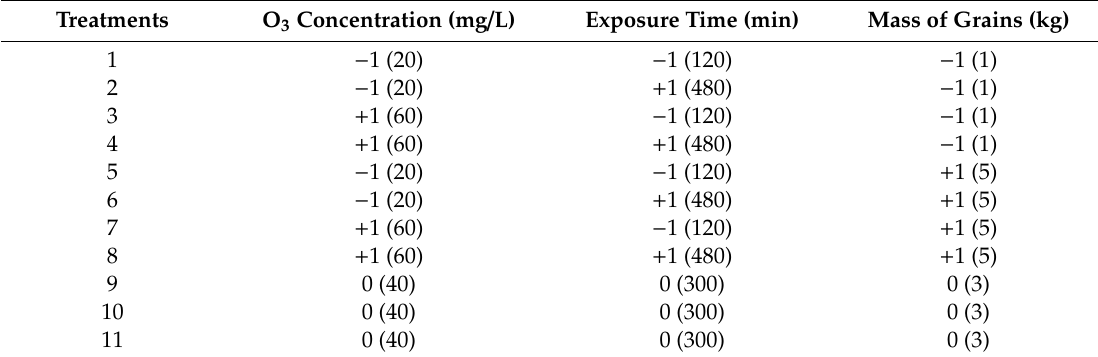
Table 1. Matrix of the full factorial design with coded and real